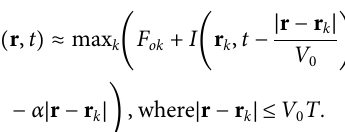
Frontiers in Earth Science |